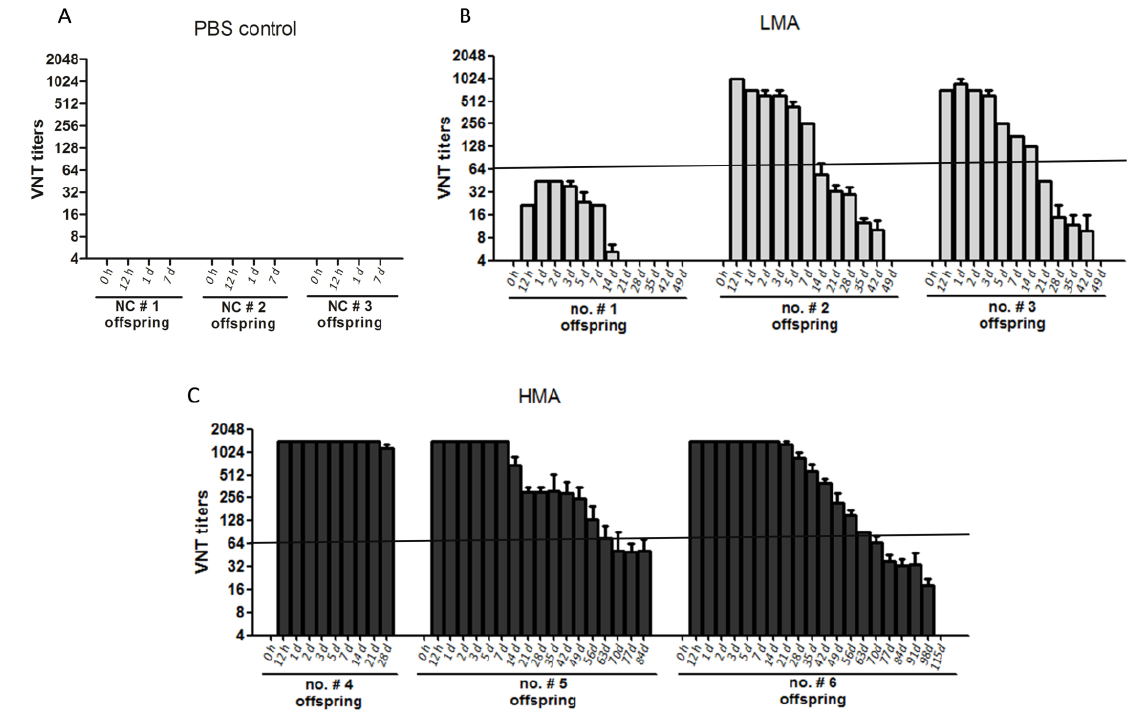
Figure 4. Dynamics of the MDAs transferred from sows to the offspring. The serum samples of the piglets in the PBS control group ( A ), the LMA group ( B ), and the HMA group ( C ) at the indicated time-point during intake of colostrum/milk were collected and subjected to VNT analysis, respectively.